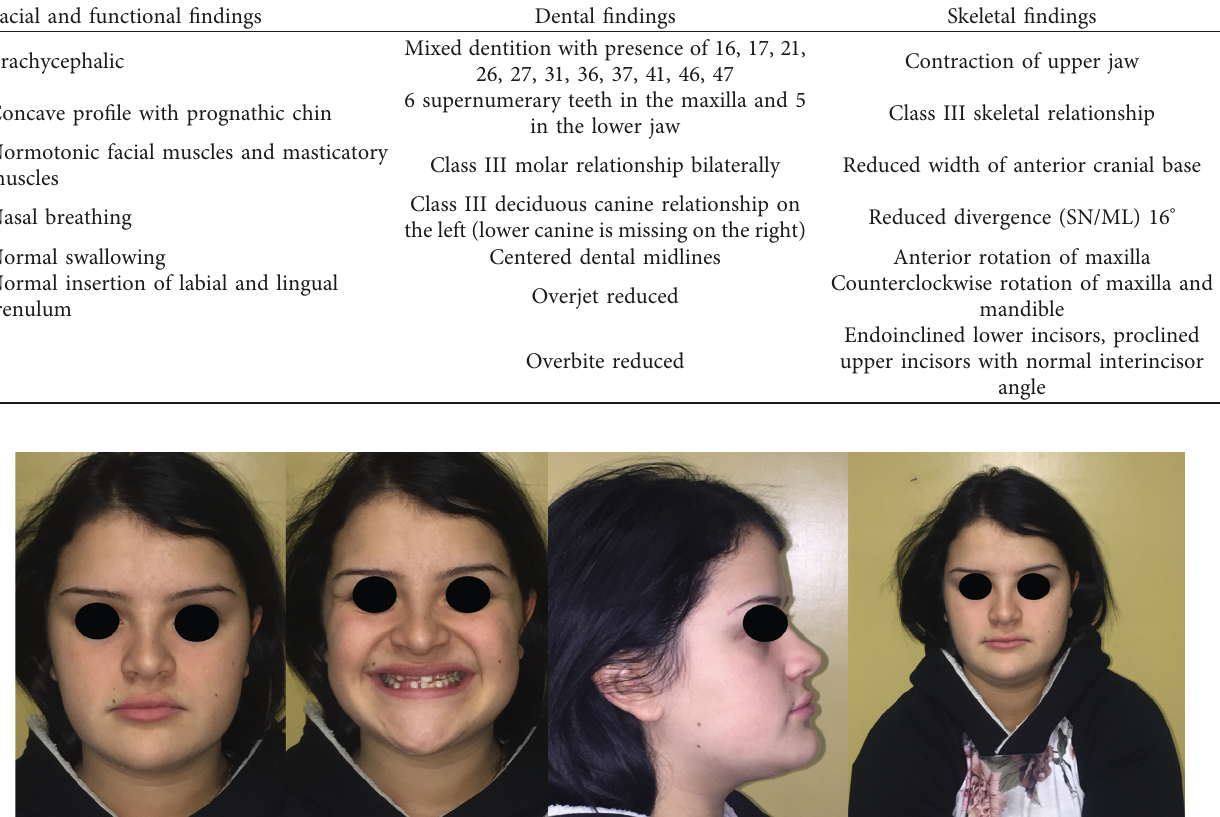
Figure 9: Case 1: pretreatment facial